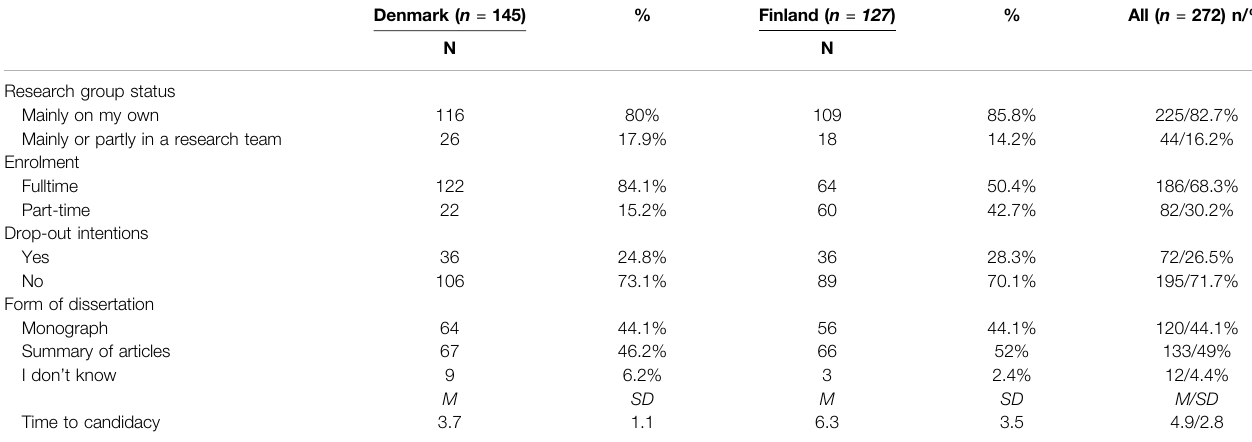
TABLE 1 | Participants ’ research group status, enrolment, drop-out intentions, form of dissertation and time to candidacy. Denmark ( n =